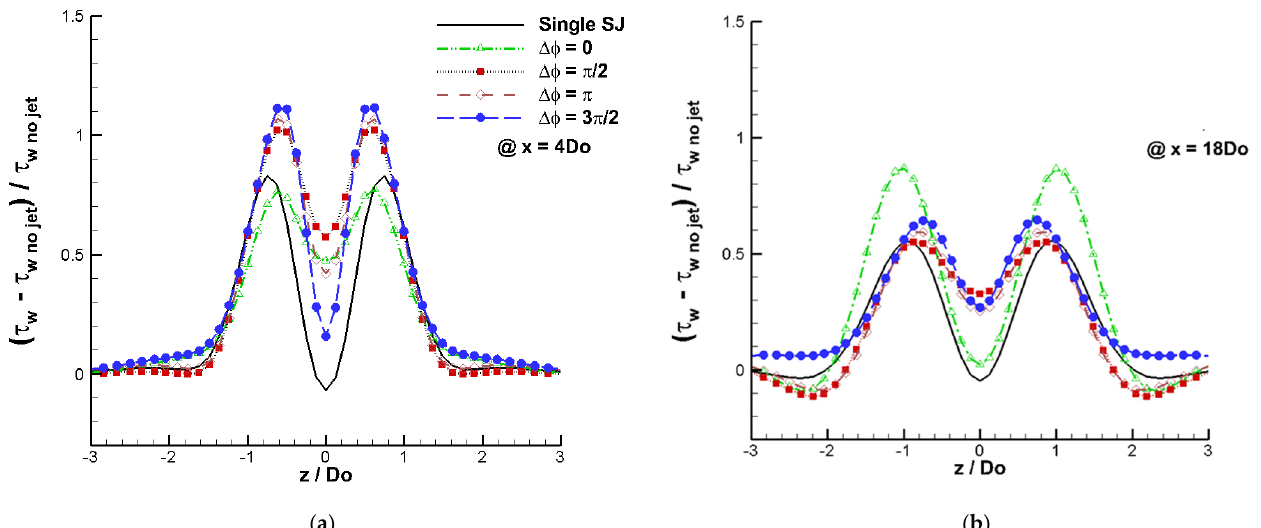
Figure 17. Time-averaged excess wall shear stress along spanwise direction at ( a ) x = 4 D o and ( b ) x = 18 D o .